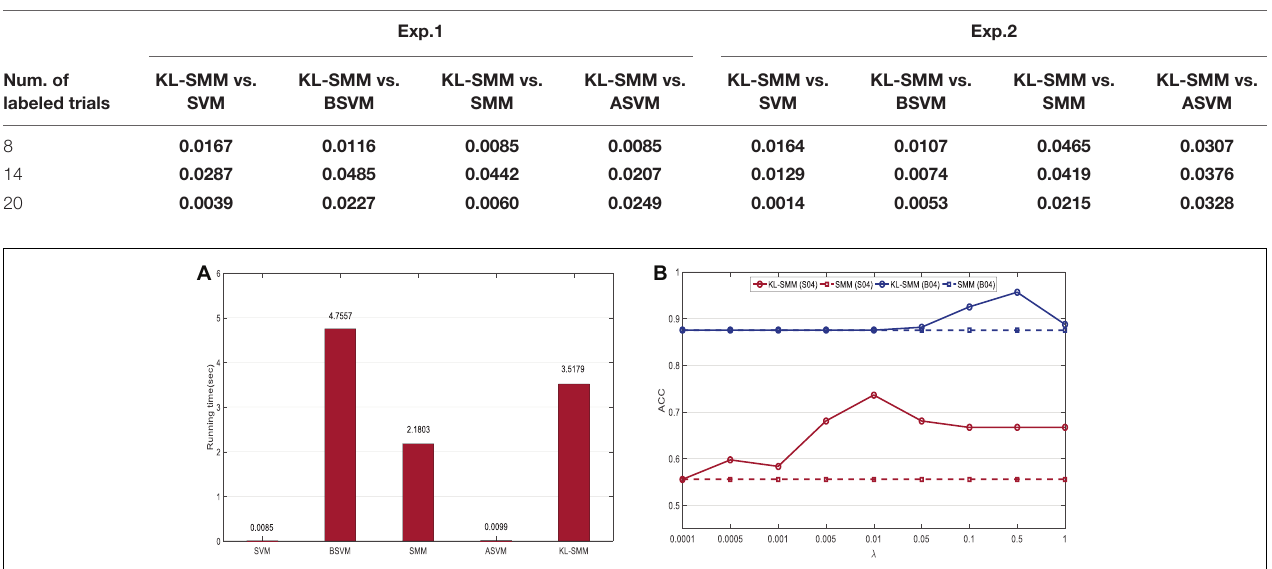
FIGURE 3 | (A) Running time for subject S01 using 14 labeled target EEG trials in Exp.1 ; (B) Parameter sensitivity of KL-SMM for the transfer tasks S04 in Exp.1 and B04 in Exp.2 using 14 labeled target EEG trials,